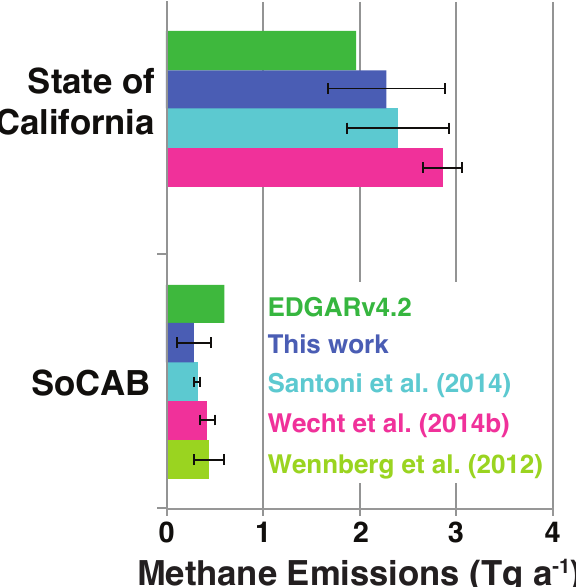
Figure 6. Methane emissions for the state of California (top) and for the Southern California Air Basin (SoCAB; bottom). Our posterior emissions (this work) are compared to prior emissions (EDGARv4.2) and to previous inverse estimates constrained by surface and aircraft observations. SoCAB is defined following Wennberg et al. (2012) as the domain 33.5–34.5 ◦ N, 117–119 ◦ W.